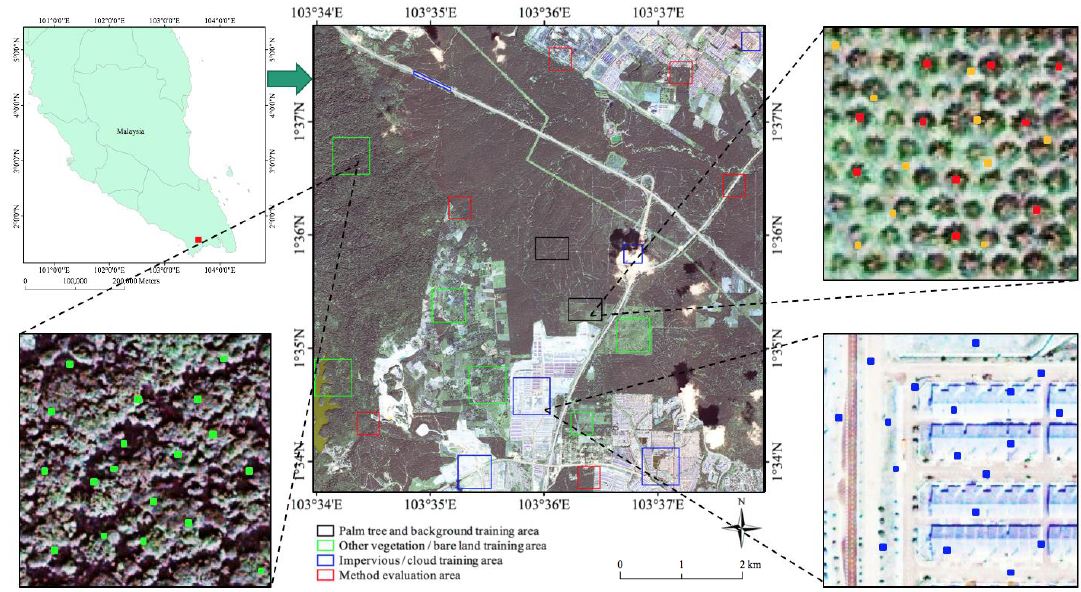
Figure 1. The location of the study area; the QuickBird satellite image used for the oil palm detection; several examples of sample coordinates collected from different regions; and six selected regions for method evaluation. The red, yellow, green, and blue points denote the oil palm tree, background, other vegetation/bare land and impervious/cloud sample coordinates, respectively.